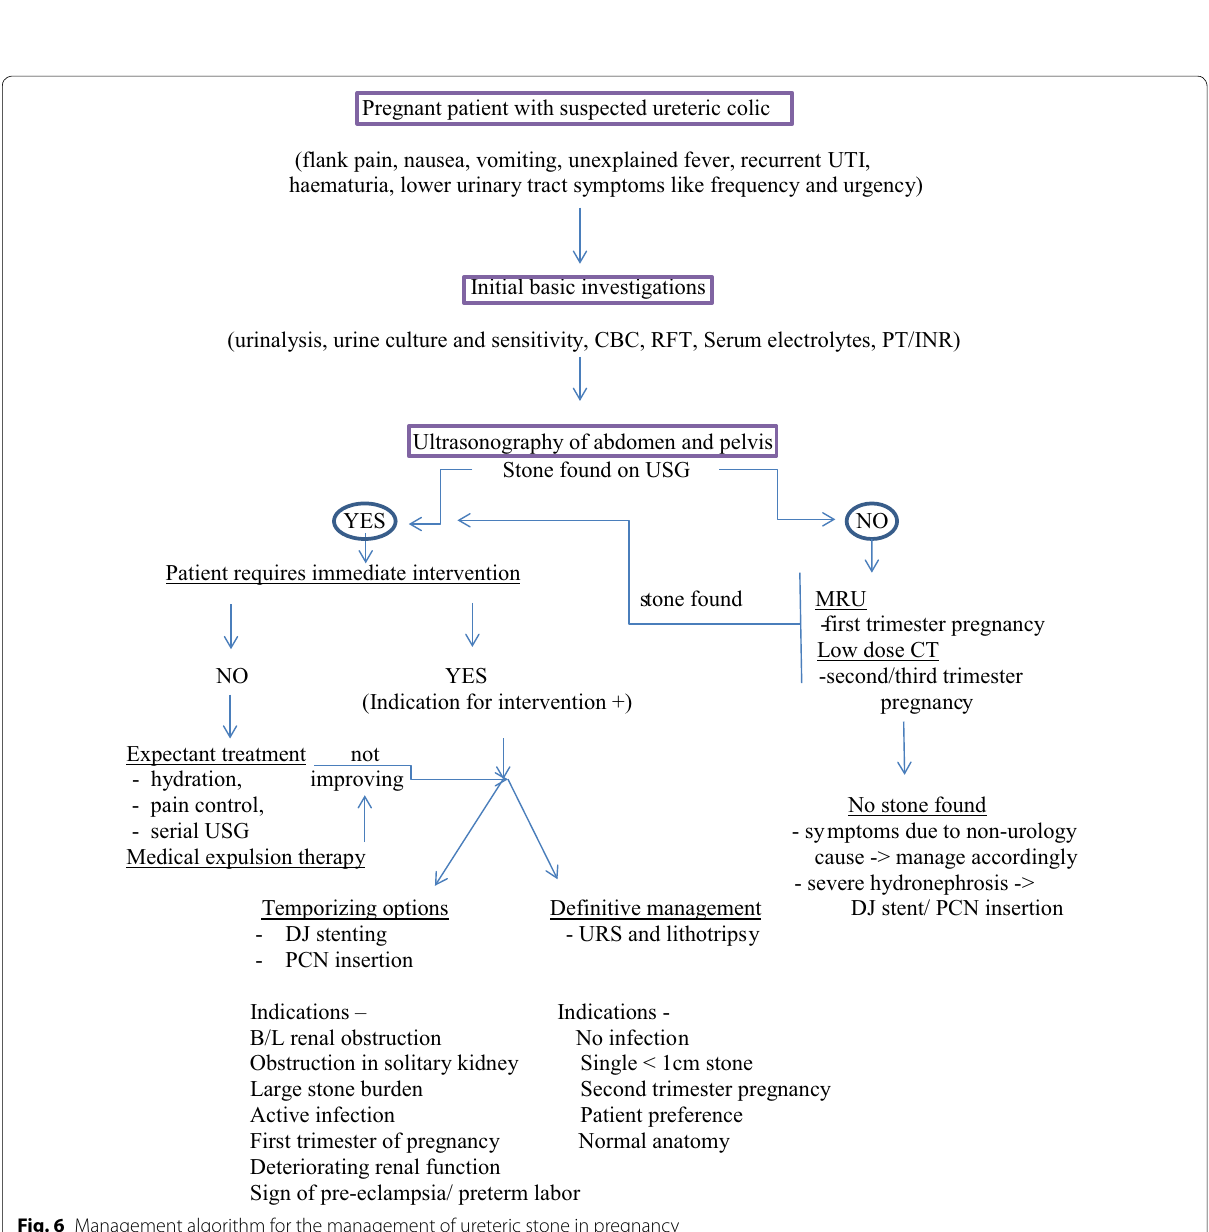
Fig. 6 Management algorithm for the management of ureteric stone in